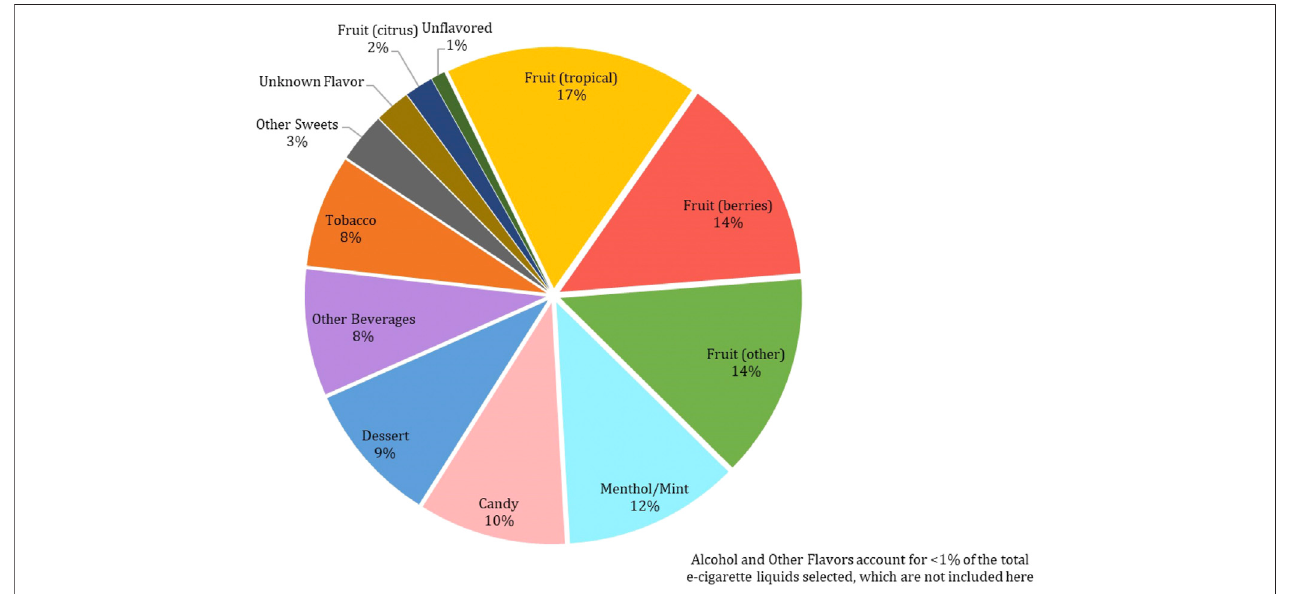
FIGURE 2 | Frequency of 215 Selected Commercial Flavored E-Cigarette Liquids by Flavor